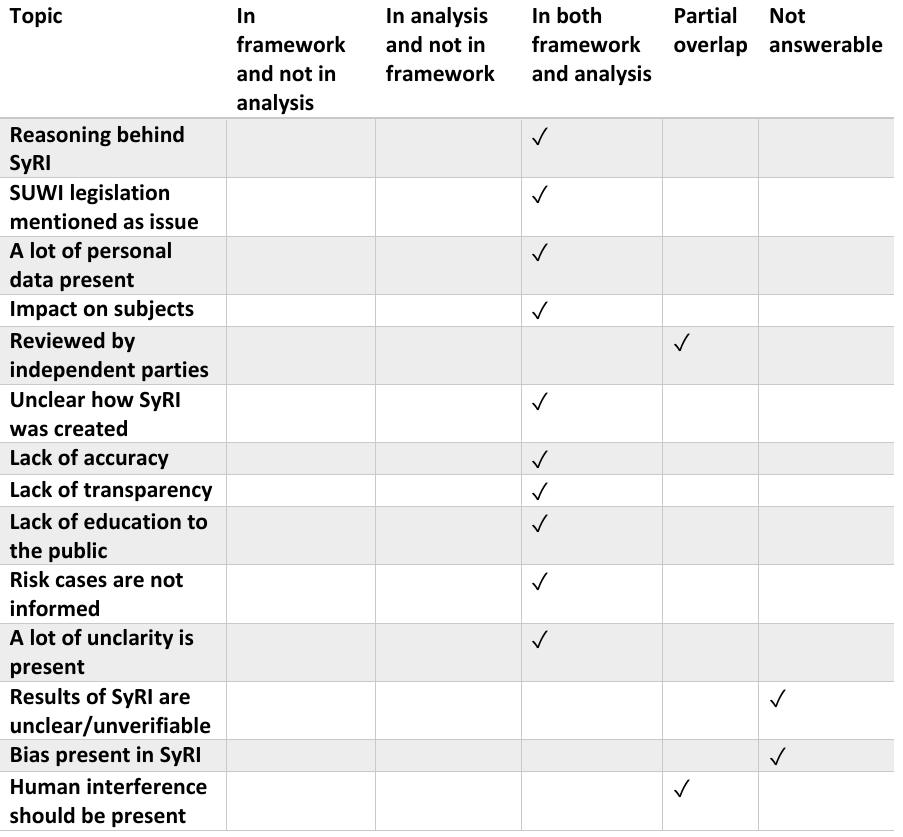
Figure 4. Comparison of specific ethical concerns between framework, the court case and the media on whether questions in the framework could be answered with a yes, maybe, no, or were not